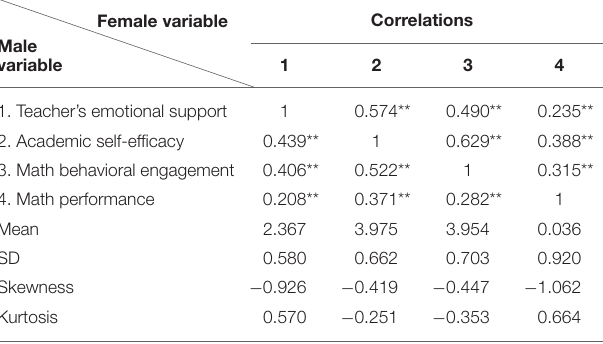
TABLE 2 | Means, SD, and intercorrelations (primary school boys and girls).